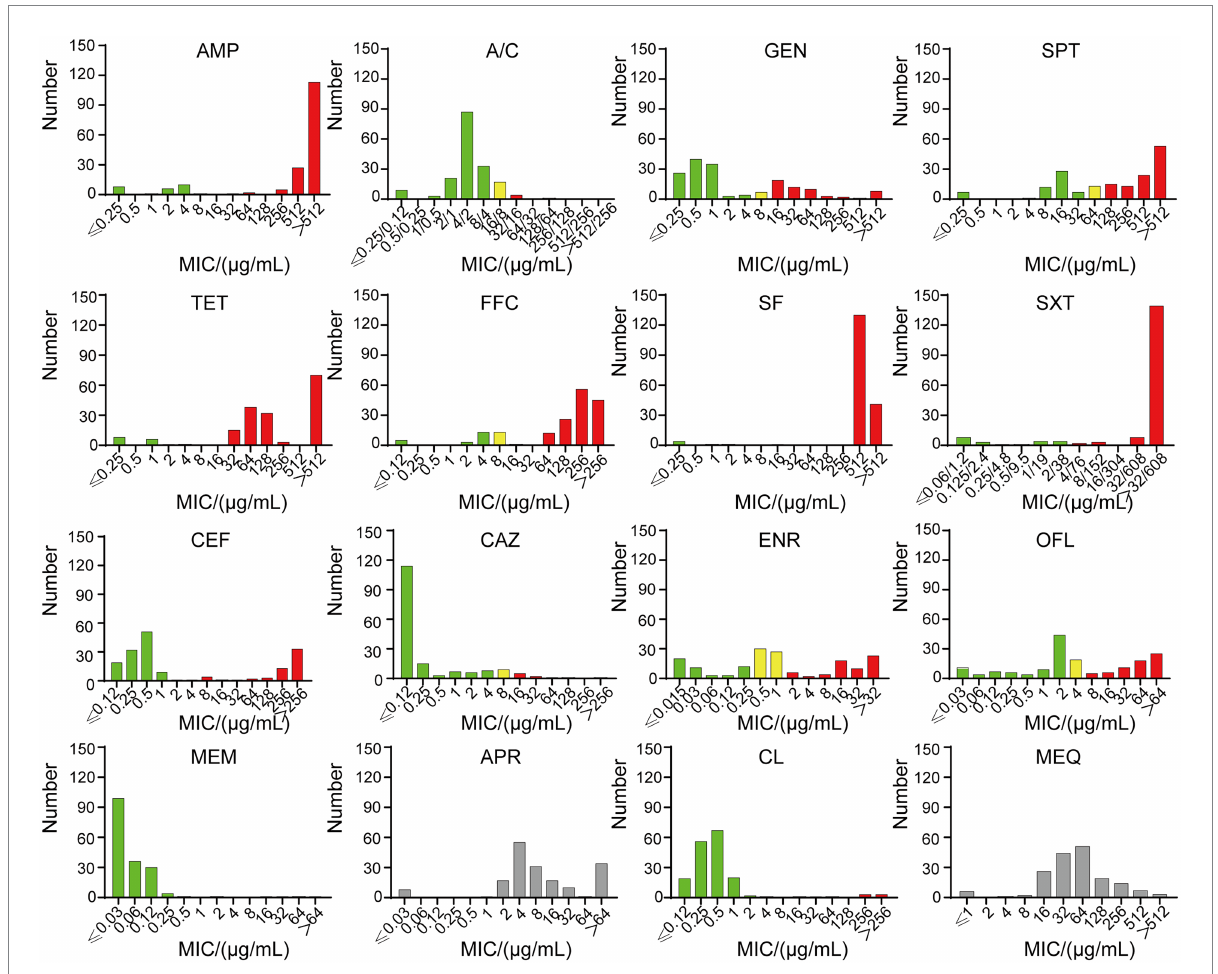
FIGURE 2 The MICs of 181 strains. Green indicates sensitivity, yellow indicates intermediary, and red indicates resistance. SF and SXT have no intermediate value, and APR and MEQ have no breakpoint. Ampicillin (AMP), amoxicillin/clavulanic acid (A/C), gentamicin (GEM), tetracycline (TET), spectinomycin (SPT), florfenicol (FFC), sulfisoxazole (SF), trimethoprim/sulfamethoxazole (SXT), ceftiofur (CEF), ceftazidime (CAZ), enrofloxacin (ENR), ofloxacin (OFL), meropenem (MEM), apramycin (APR), colistin (CL) and mequindox